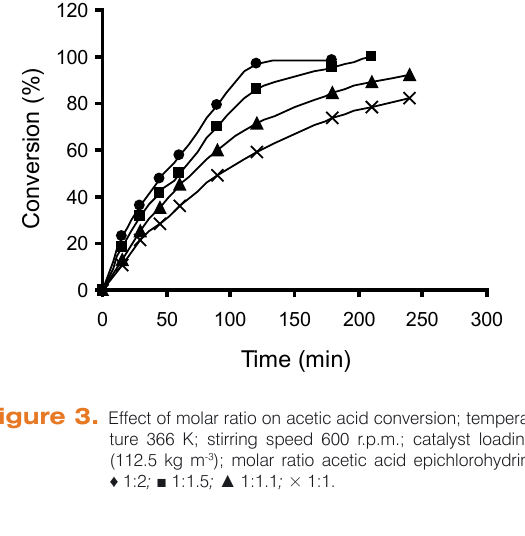
y = 6.0204x + 9.8752